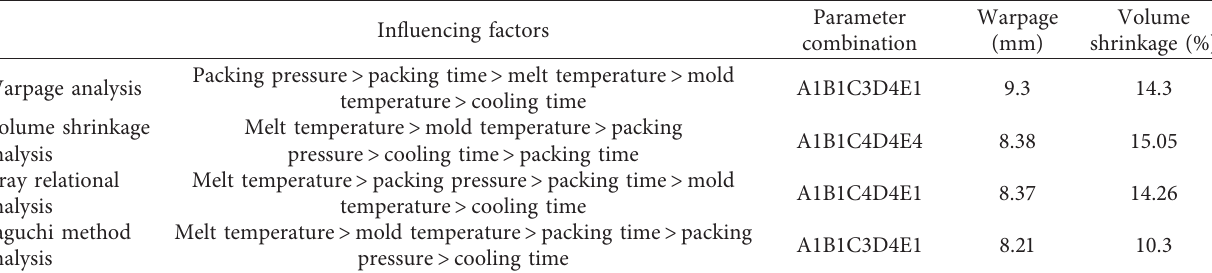
Figure 13: A1B1C3D4E1 combined simulation results with (a) warpage and (b) volume Table 15: Comprehensive analysis and comparison.